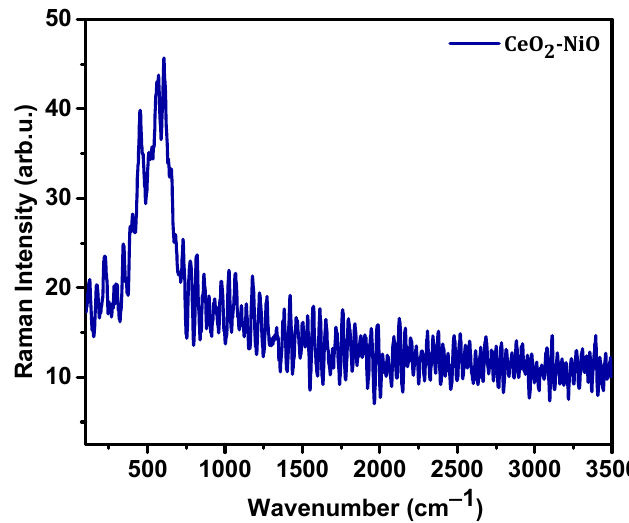
Figure 7. Raman spectrum of CeO 2 /NiO nanocomposite.